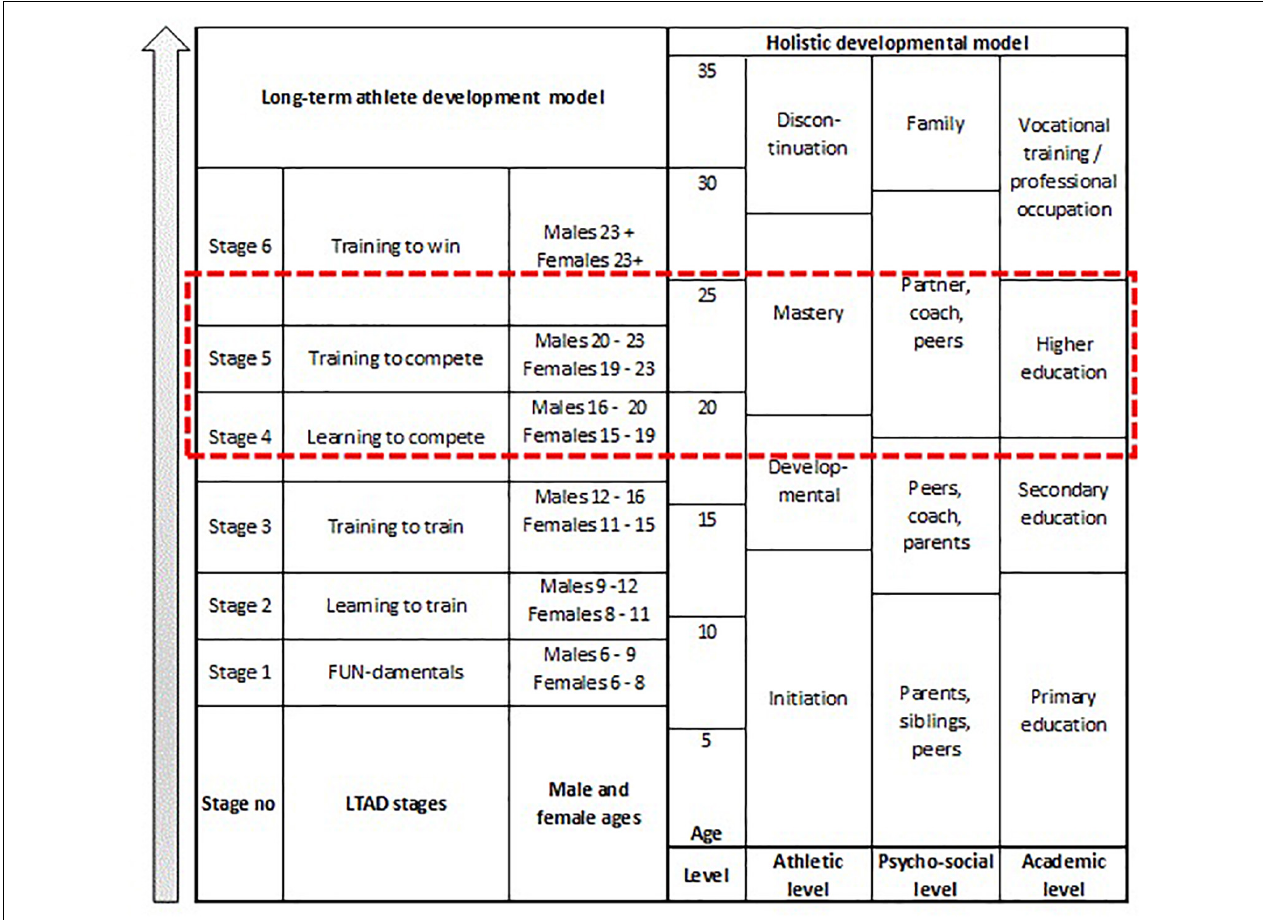
FIGURE 1 | Combined models of LTAD (Balyi et al., 2013) and holistic perspective development (Wylleman and Lavallee,